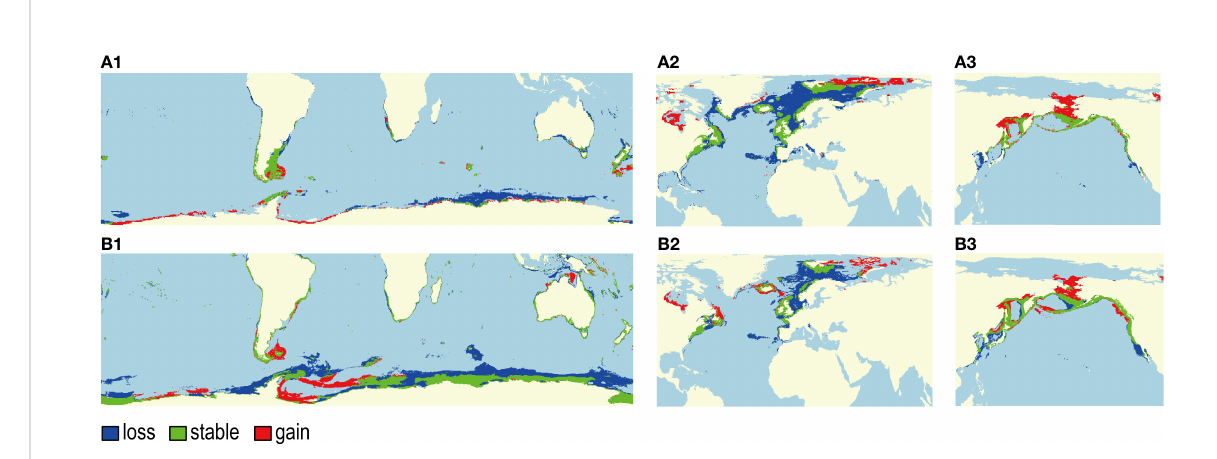
FIGURE 8 Change in future habitat suitability projected by the species-level model (A1 – A3) and population-level model (B1 – B3) for the Southern Hemisphere population (SHP), the North Atlantic population (NAP) and the North Paci fi c population (NPP) of the common minke whale respectively in the 2100s under the representative concentration pathway (RCP) 8.5. The category “ Loss ” represents areas projected to be suitable under current climatic conditions but unsuitable under future climatic conditions; “ Stable ” represents areas projected to be suitable under both current and future climatic conditions; and “ Gain ” represents areas projected to be unsuitable under current climatic conditions but suitable under future climatic